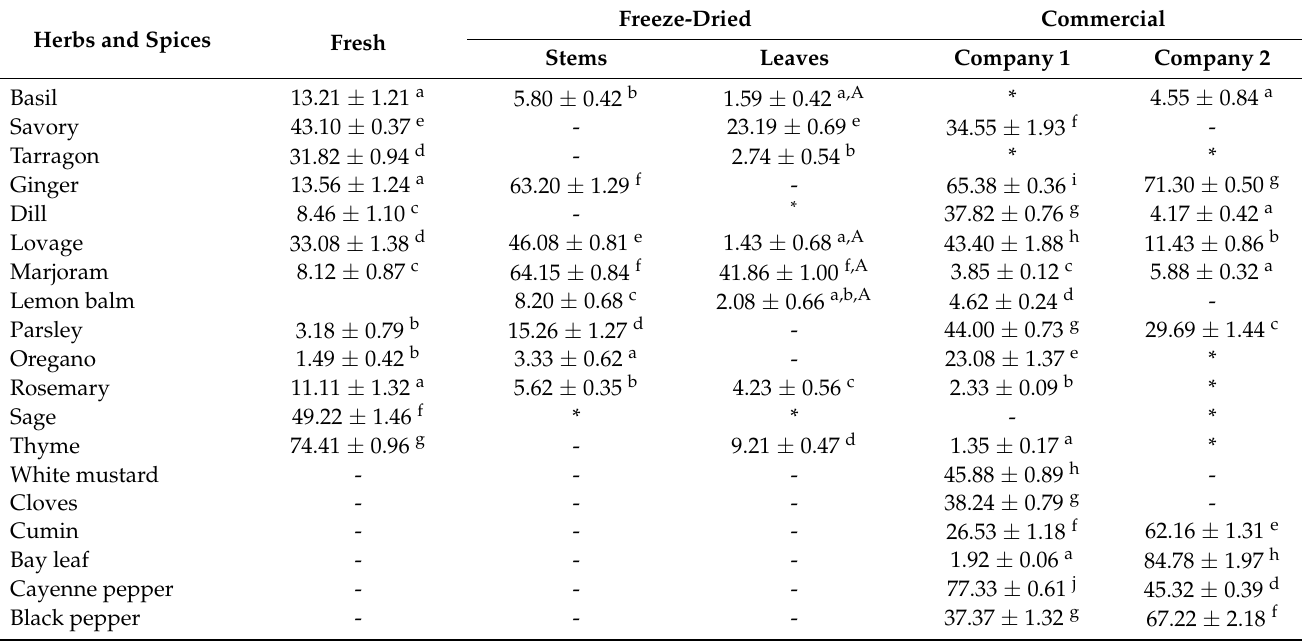
Table 3. Antioxidant activity of fresh and freeze-dried herbs and spices measured by the DPPH method (%